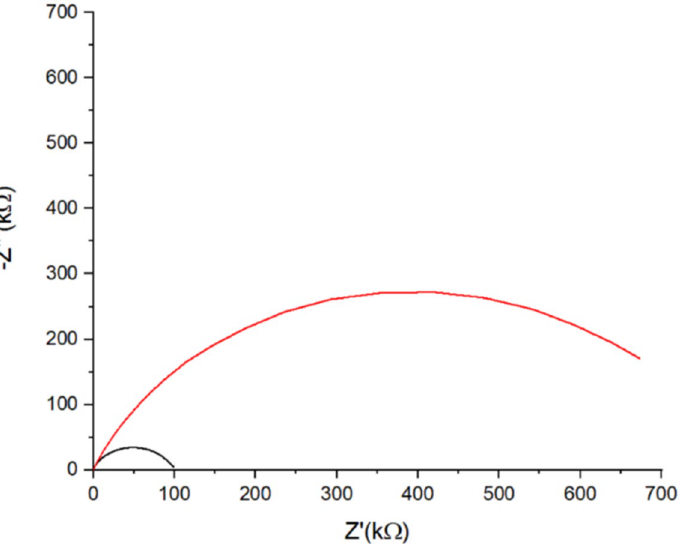
Figure 3. Nyquist plot of HDT-modified electrode before (black curve) and after (red curve) Dd-OT intercalation.